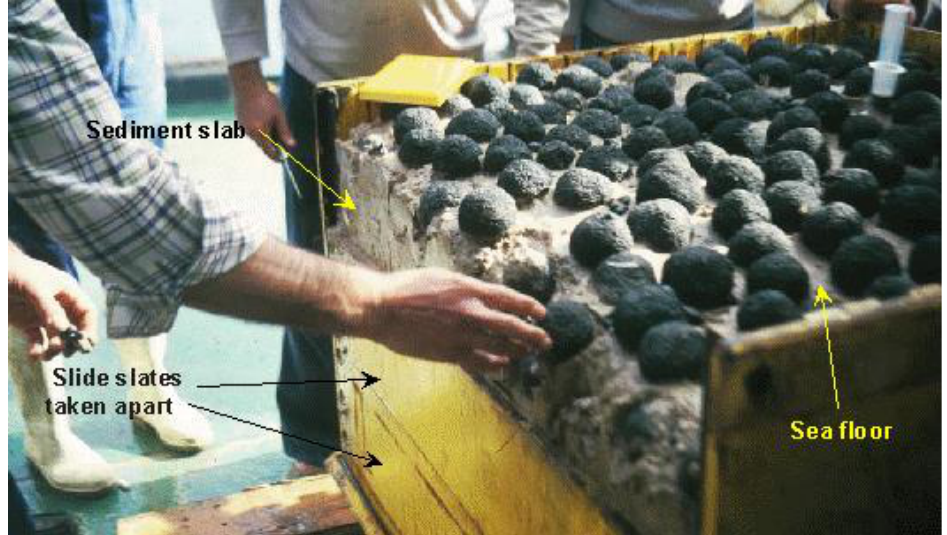
Figure 16. Nodules and mud in a box corer (SYMPAS). Source: Museum National d’Histoire Naturelle [61].